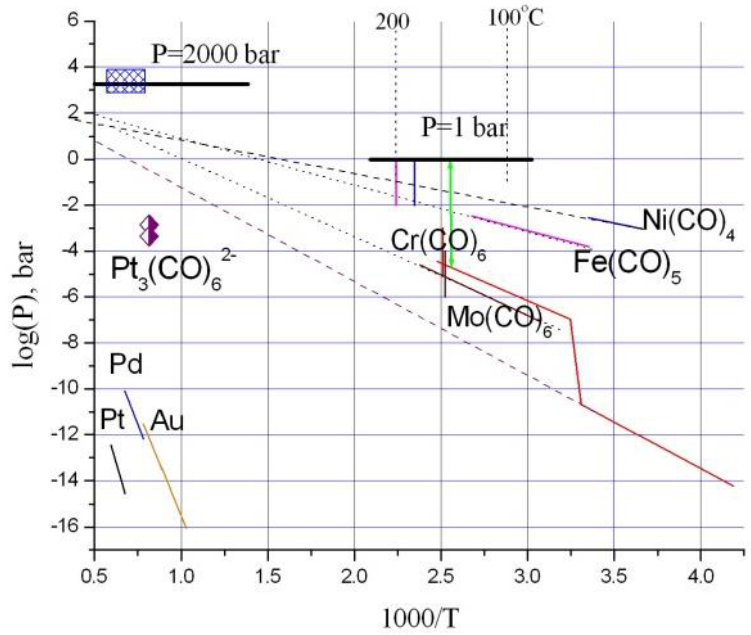
Figure 1. Vapor pressures of carbonyls of the transient metals and PGE according to the experimental data [17,18]. Vertical lines depict decomposition temperature at P = 1 bar. Value of the partial pressure of Pt carbonyl is plotted in accordance to our experimental data. Crossed rectangle corresponds to the typical PT parameters of the cumulus processes in the ultramafic–mafic intrusions.